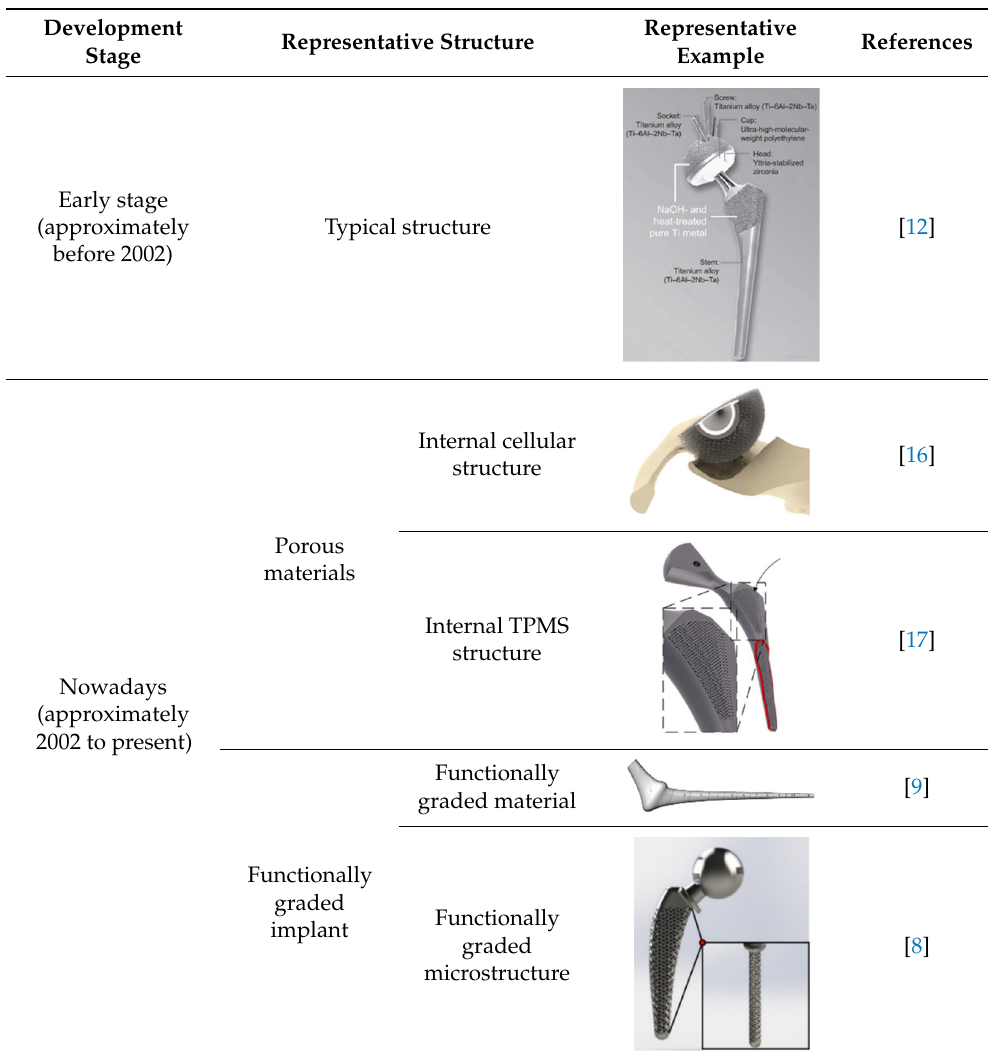
Table 2 summaries the evolution of the microstructures of implants; porous micro-